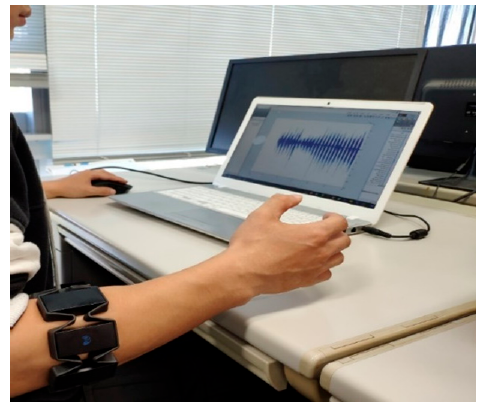
Figure 9. The environment settings of EMG data obtaining.